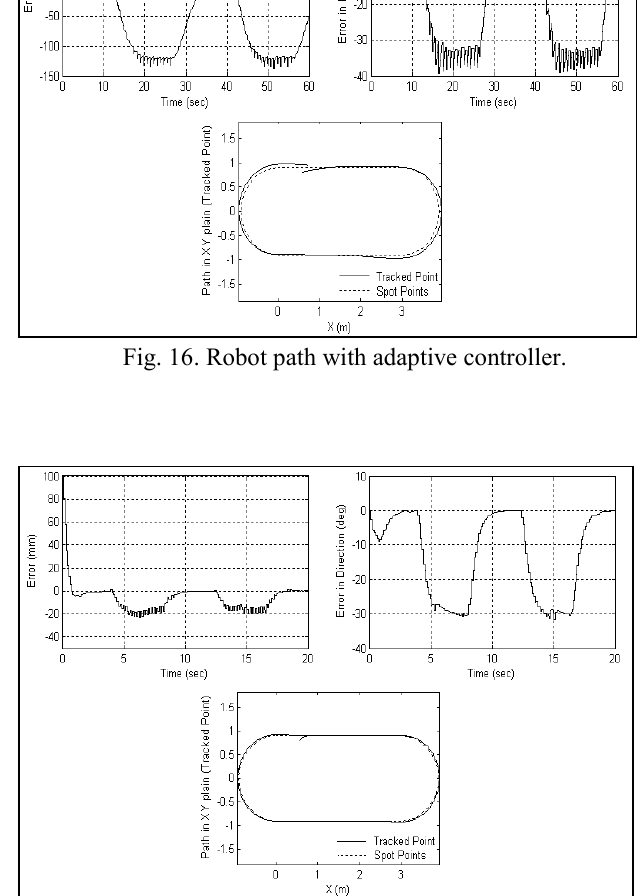
Fig.17. Robot path with MPC